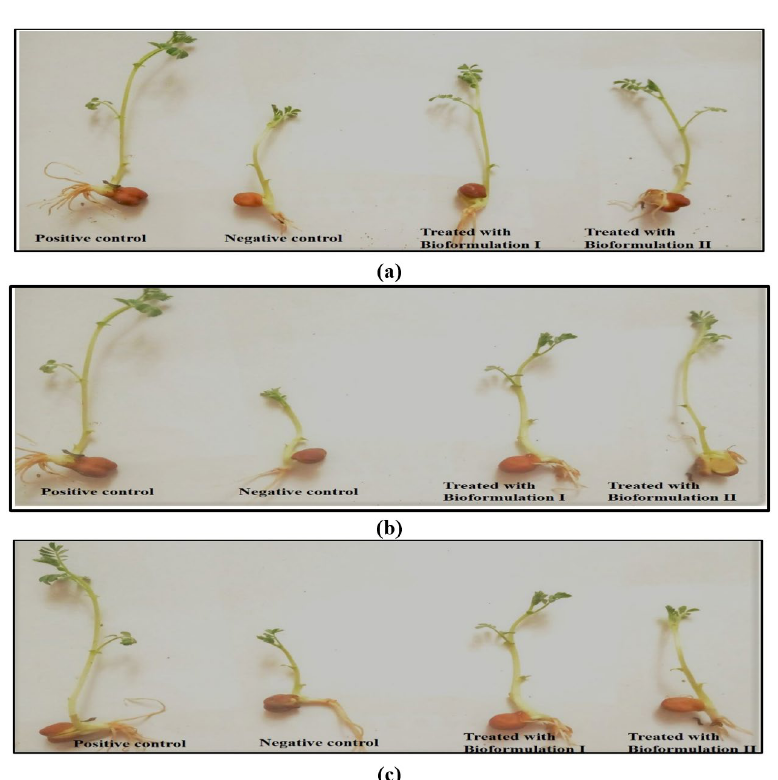
Fig. 10. Plant Growth of Cicer arietinum in samples of a) Electroplating industry b) Battery industry c) Steel